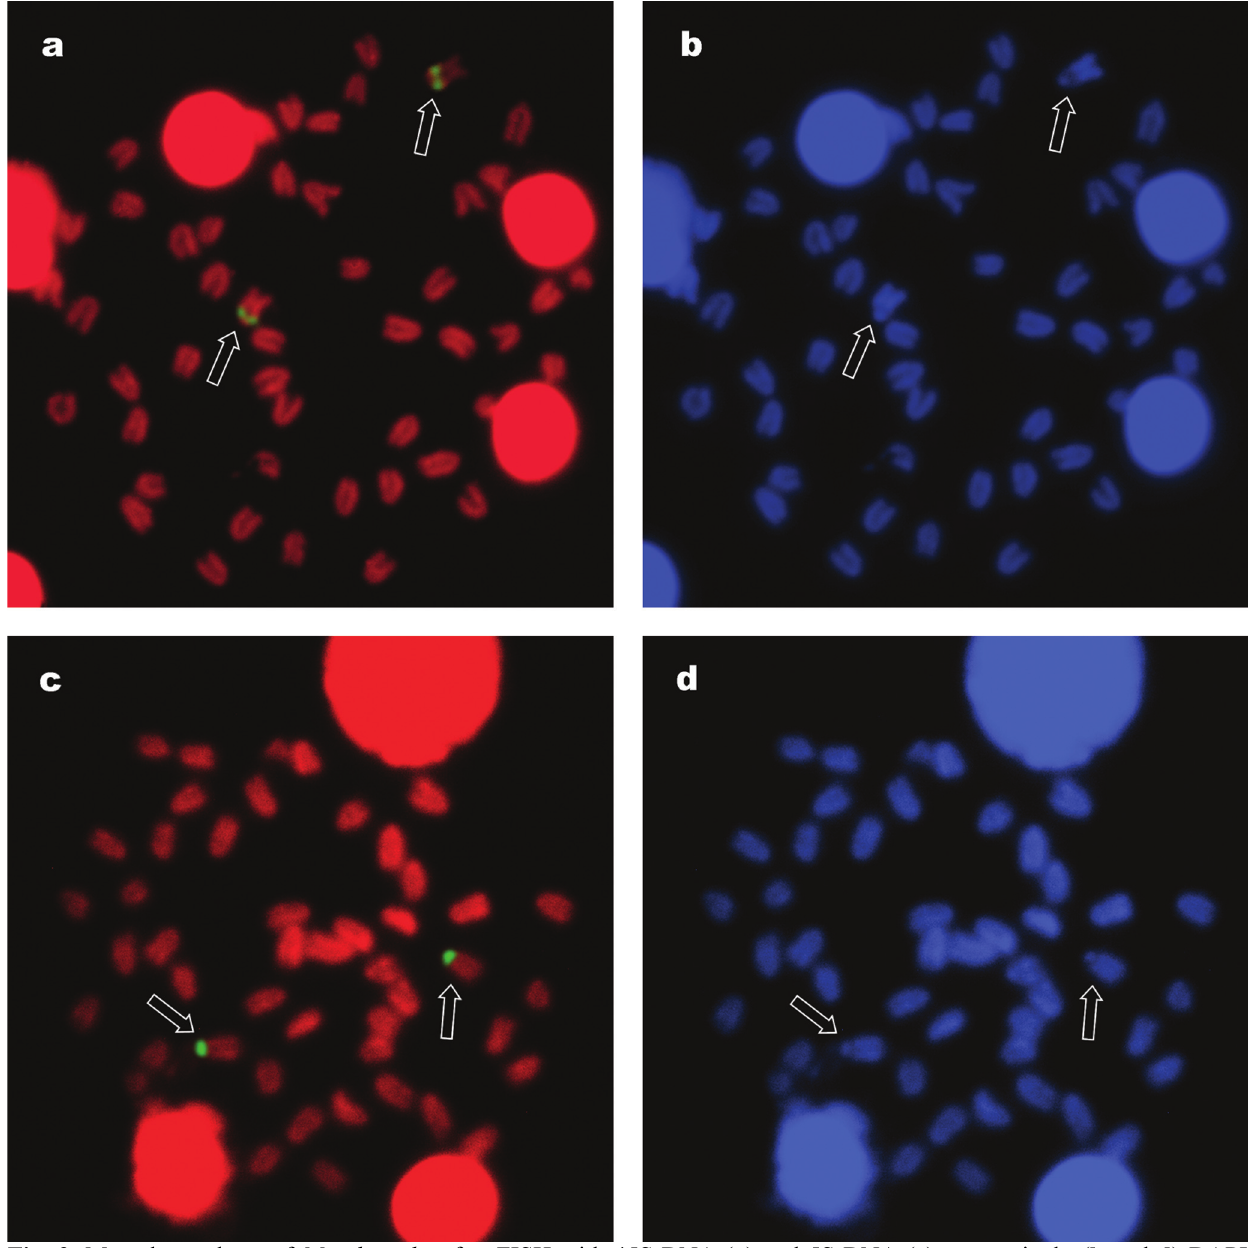
Fig. 3. Metaphase plates of Mugil incilis after FISH with 45SrDNA ( a ) and 5SrDNA ( c ), respectively ( b and d ) DAPI counterstained. Arrows indicate chromosome pair number